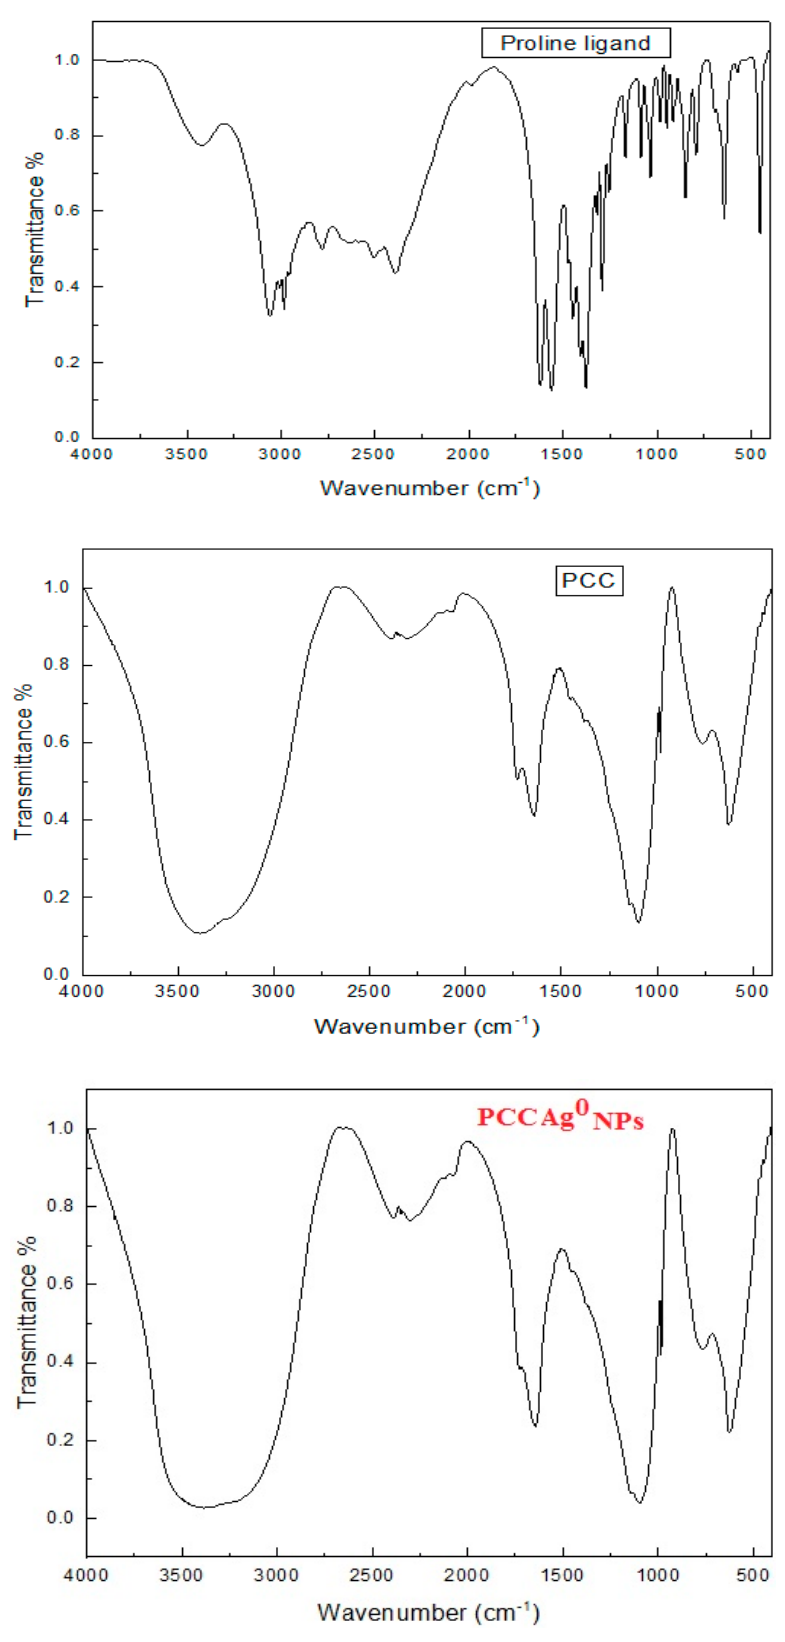
Figure 2. FTIR spectra of single crystal.